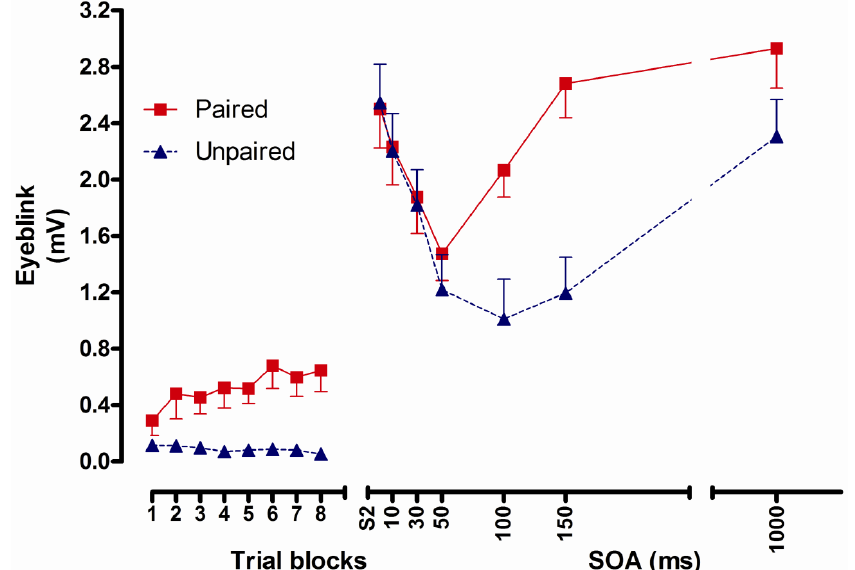
Figure 2. Left panel: Conditioned eyeblink responses in the paired and unpaired groups in the conditioning phase. Error bars represent 1 standard error of the mean. Right panel: Noise UR magnitudes across SOAs. S2 denote noise alone